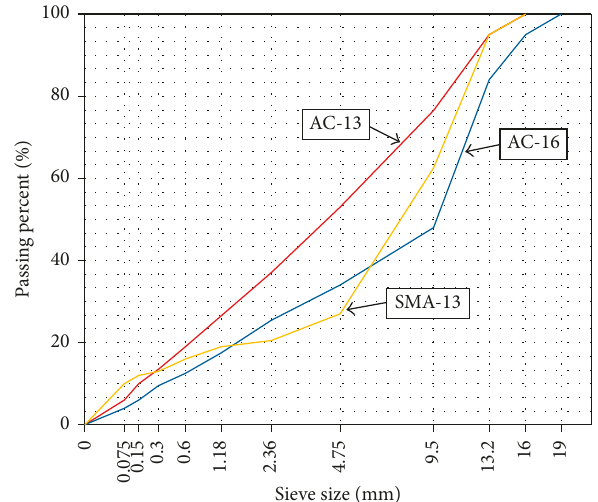
Figure 1: Experimental gradation curves for 0.45 power gradation graph.